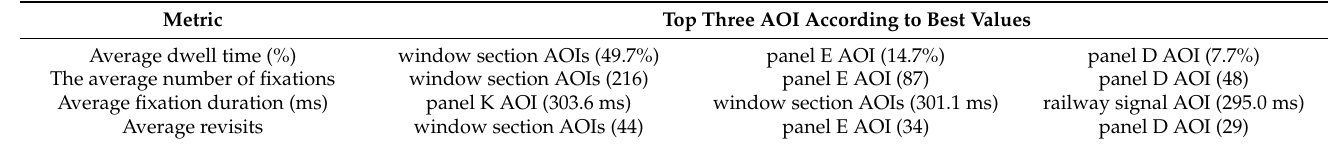
Table 4. The arrival procedure’s average statistic for train station Doln ý Hriˇcov.